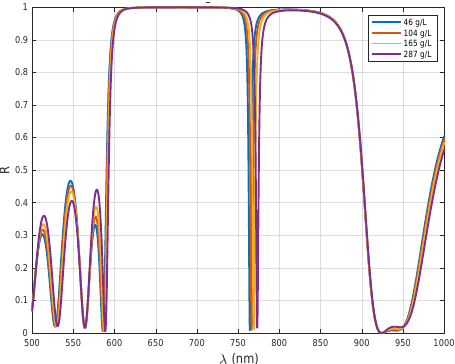
Figure 3. Reflectance spectra of hemoglobin sample-filled structure.